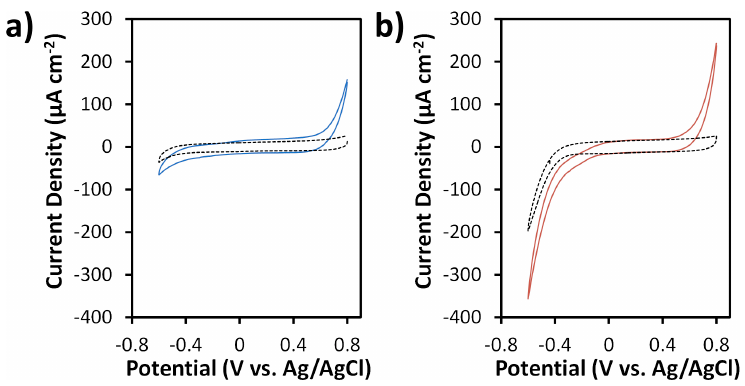
Figure 5. CVs of SPCE ( a ) and N-SPCE ( b ) in the absence (dashed lines) and presence (solid lines) of 20 mM H 2 O 2 in 0.05 M phosphate buffer (pH 7.4). All CVs were obtained at a scan rate of 50 mV s − 1 . 20 mM H ff er (pH 7.4). All CVs were obtained at a scan rate of 50 mV s − 1 2 O 2 in 0.05 M phosphate bu